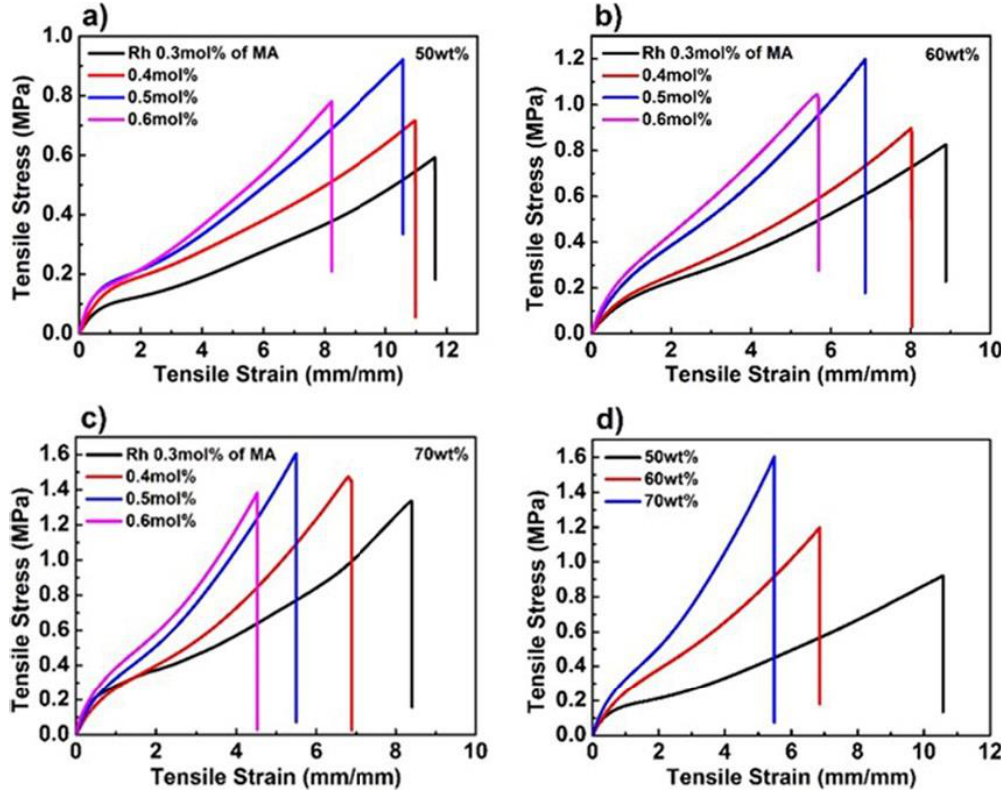
Figure 2. Mechanical properties of the poly(AAm-co-MA/Rh) hydrogel. ( a ) Tensile stress – strain curves of poly(AAm-co-MA/Rh) hydrogels with a solid content of 50 wt%, ( b ) 60 wt%, ( c ) 70 wt%, and Rh-crosslinker concentrations of 0.3, 0.4, 0.5, and 0.6 mol% of methyl acrylate (MA), respectively. ( d ) Tensile stress – strain curves of poly(AAm-co-MA/Rh) hydrogels with a solid content of 50, 60, 70 wt% and the same Rh crosslinker concentration of 0.5 mol% of MA.